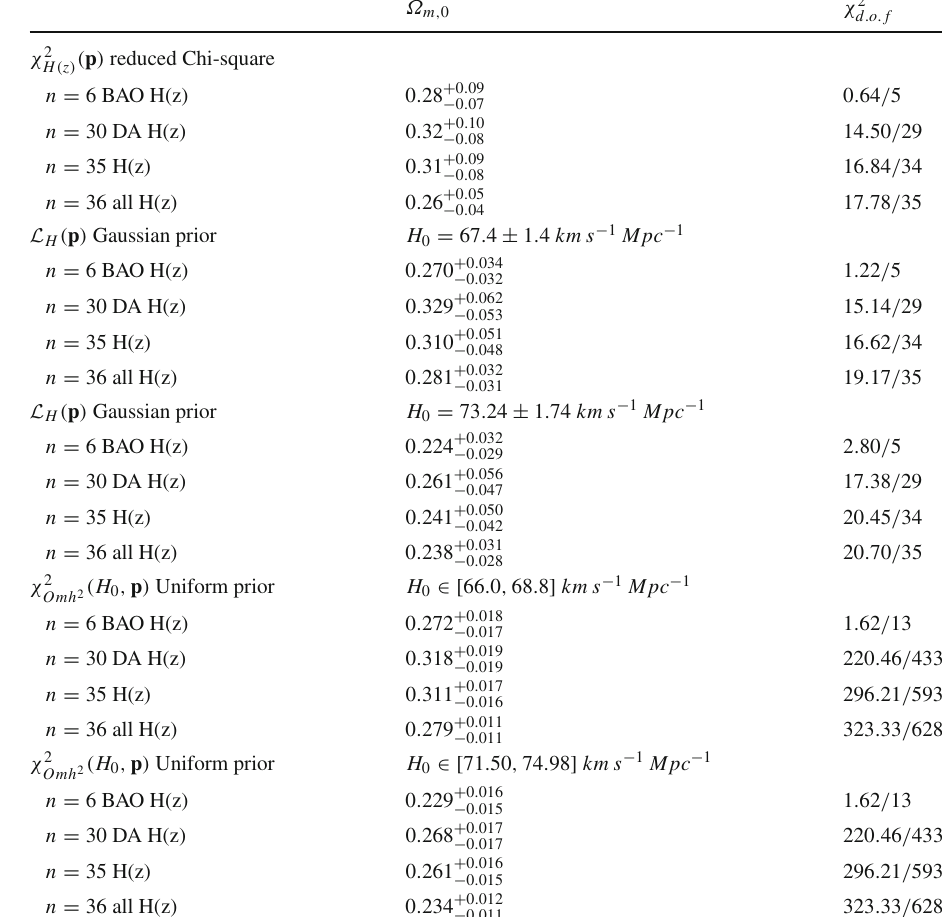
Table 1 Best fitted